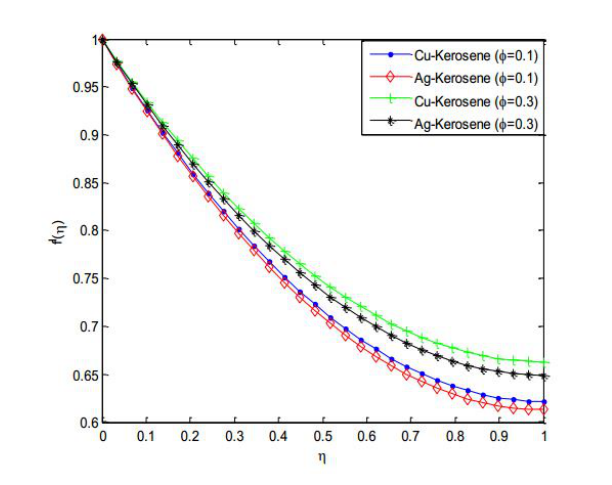
Figure 16. Effect of nanoparticle volume fractions on the fluid velocity distribution